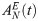
Mesoscopic dynamics of E-I network for varying network size N, connection probability p and number of synapses per neuron C.(A) Left: Schematic of the network of NE excitatory and NI = NE/4 inhibitory leaky integrate-and-fire (LIF) neurons, each receiving CE = pNE (CI = pNI) connections from a random subset of excitatory (inhibitory) neurons. Total numbers are N = NE + NI and C = CE + CI. At C = 200, the synaptic strength is w = 0.3 mV and −gw = −1.5 mV for excitatory and inhibitory connections, respectively. To preserve a constant mean synaptic input, the synaptic strength is scaled such that Cw = const‥ Right: Schematic of a corresponding mesoscopic model of two interacting populations. (B) Trajectories of u(t) for five example neurons (top) and of the excitatory population activity ANE(t) obtained from the network simulation (middle) and the mesoscopic simulation (bottom, dark green) for C = N = 50; time resolution Δt = 0.2 ms. The light green trajectory (bottom panel) depicts the expected population activity A¯E(t) given the past activity. (C) Power spectra of ANE(t) for different network sizes while keeping p = 1 fixed (microscopic: symbols, mesoscopic: solid lines with corresponding dark colors). (D) Sample trajectories corresponding to the green curve in (E) (N = 1000, p = 0.2). (E) Analogously to (C) but varying the connection probabilities while keeping C = pN = 200 fixed. (F) Sample trajectories corresponding to the green curve in (G) (N = 200, C = 40). (G) Analogously to (C) but varying the number of synapses C while keeping N = 200 fixed. Note that the mesoscopic theory (black solid line) is independent of C because the product Cw, which determines the interaction strength in the mesoscopic model (see, left panel of (A)), is kept constant. Parameters: μE/I = 24 mV, ΔuE/I=2.5 mV and θE/I(t) ≡ 0 (no adaptation).